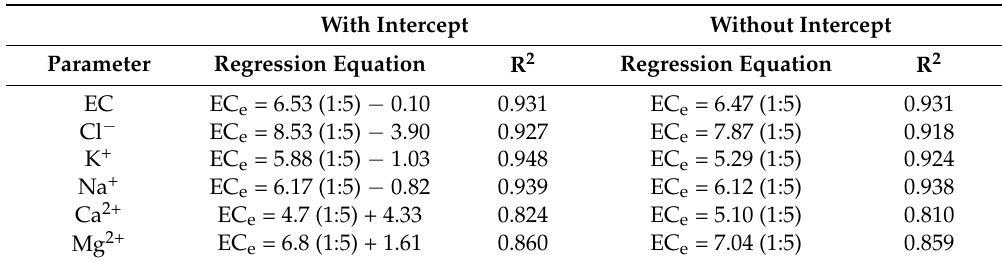
Table 5. Regression equations describing the relation between EC 1:5 and saturated paste extracts EC e (N = 198) and ion concentrations along with the coefficients of determination (R 2 ) (N = 123). With Intercept Without Intercept Parameter Regression Equation Regression